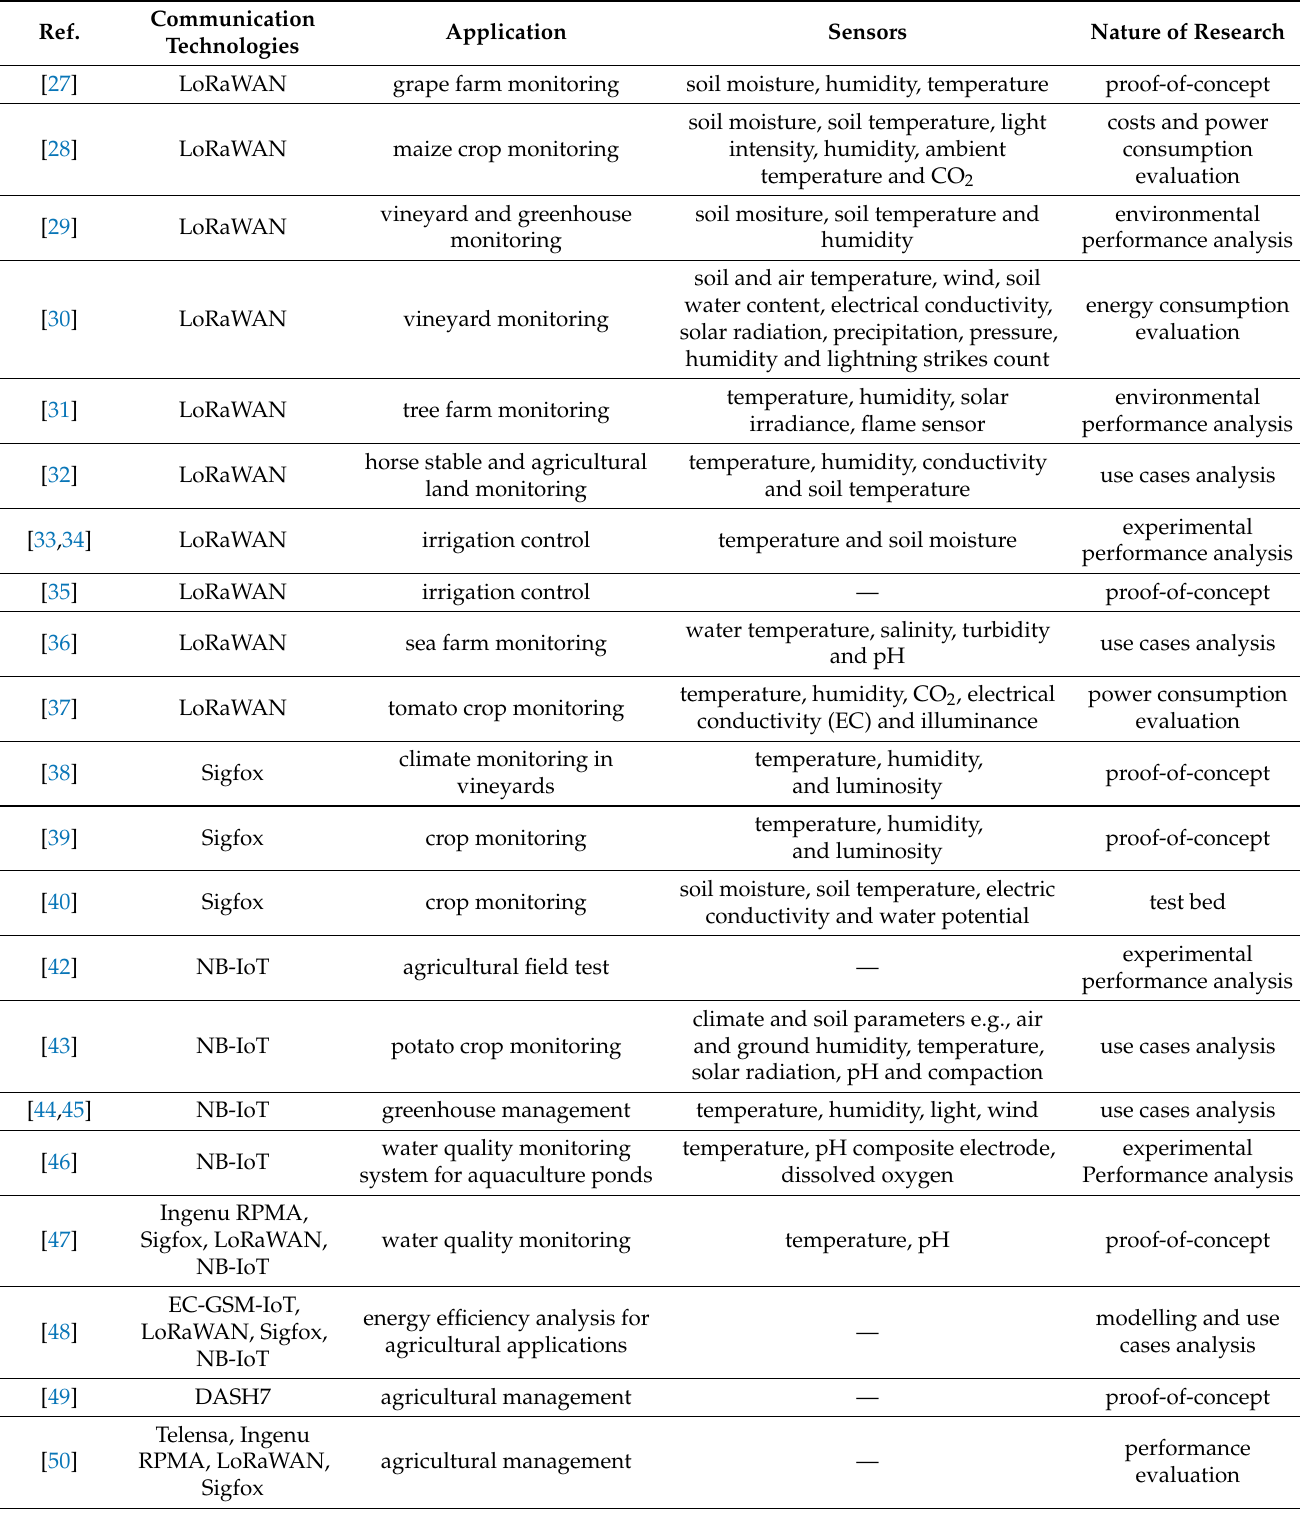
Table 2. A Summary of Related Works.